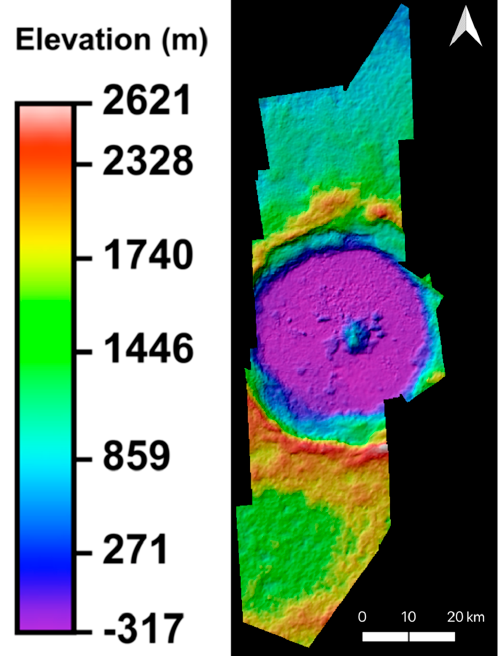
Figure A9. Sander Crater. Anaglyphs of DEMs containing hollowed regions. Note that anaglyphs are vertically exaggerated by approximately 10× the true vertical distance.